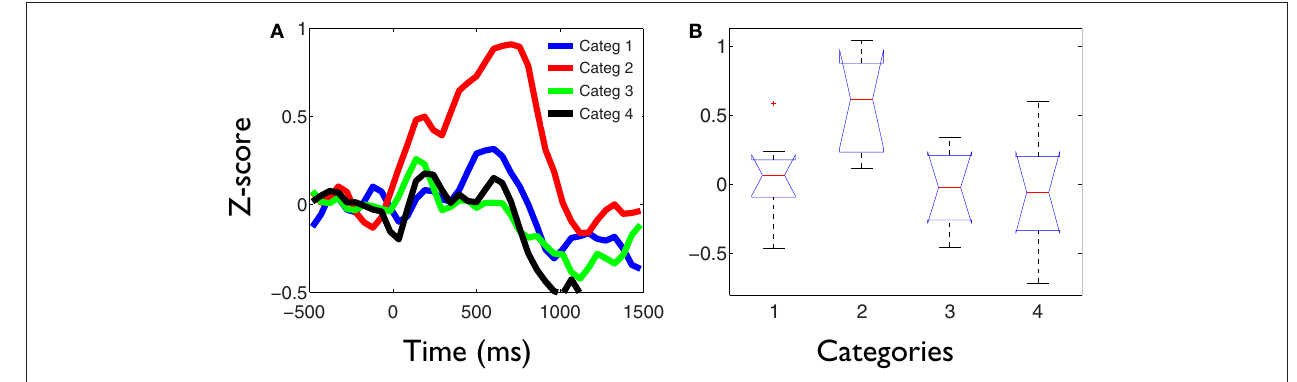
FIGURE 2 | Delta-theta phase synchronization increments are significantly larger for the kept in mind category. (A) Temporal profile of the average phase synchronization changes during the task, in the frequency range between 1 and 6Hz for each category. Each signal represents the average of the Z -score values across all valid pairs of electrodes and subject, during the task. At all temporal-frequency windows, defined as regions of interest within these bands, the average phase synchronization increments for the kept in mind category (2) were